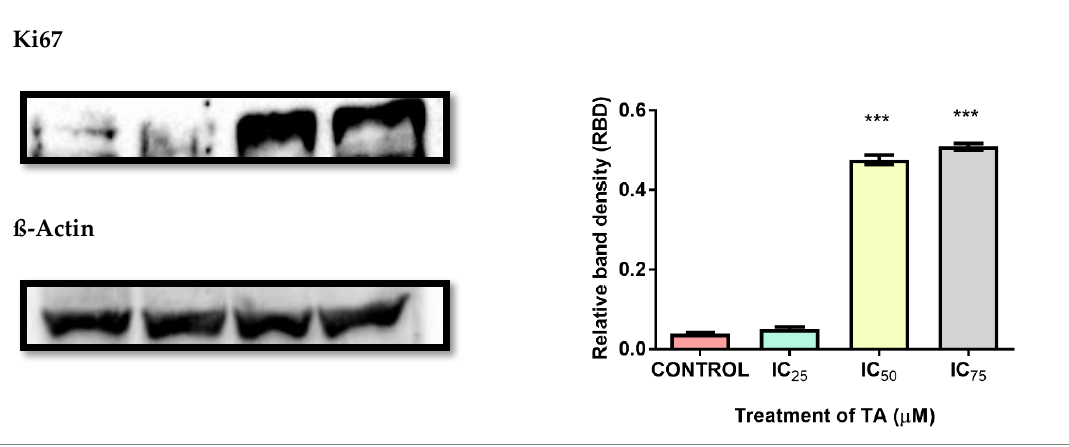
Figure 8. Differential expression of proliferation marker Ki67 in Hek-293 cells following treatment for 24h. All treatments exhibited an upregulation in protein expression, inferring an increased rate of proliferation. (*** p < 0.0001 ).